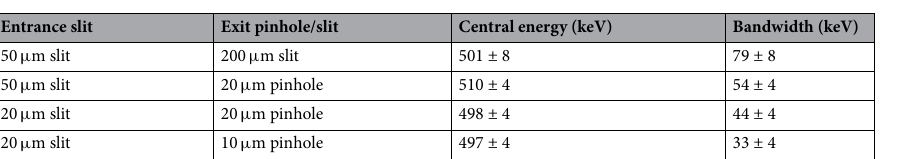
Table 1. The energy bandwidth of selected configuration of entrance slit and exit pinhole.